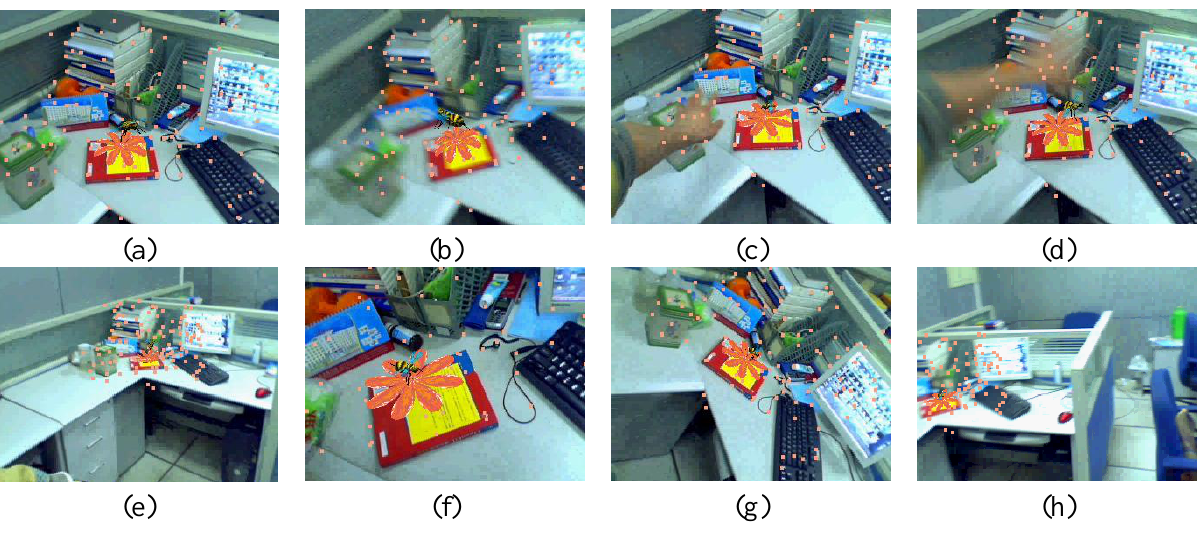
Figure 4. Results of the first indoor